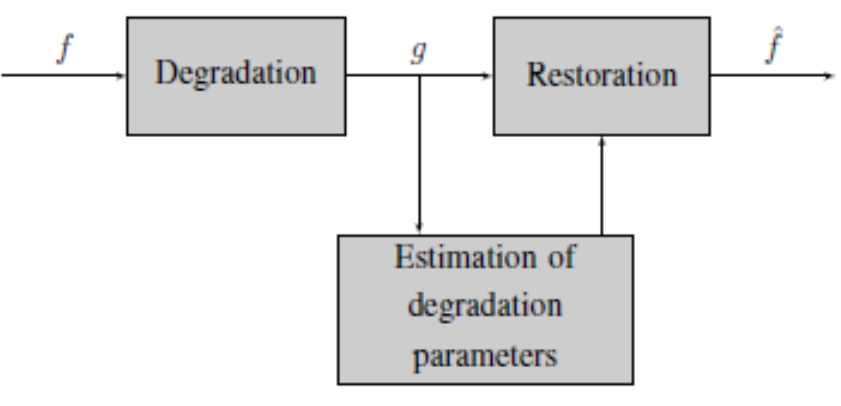
Fig. 2. Image restoration